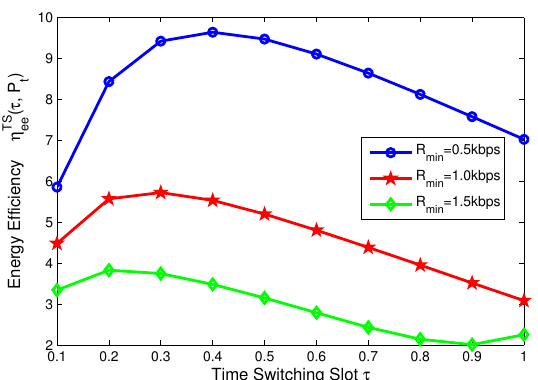
Figure 17. Energy efficiency versus power splitting ratio with different minimum QoS requirements for TS mode.